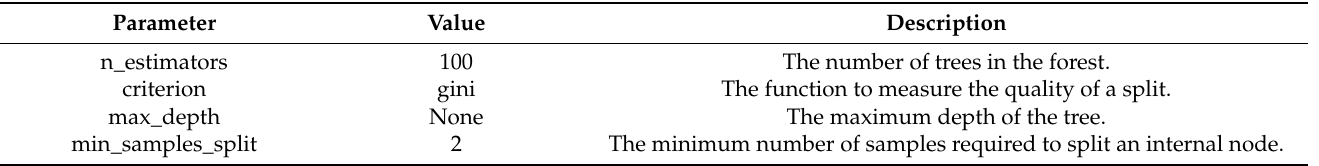
Table 7. Random forest algorithm parameters